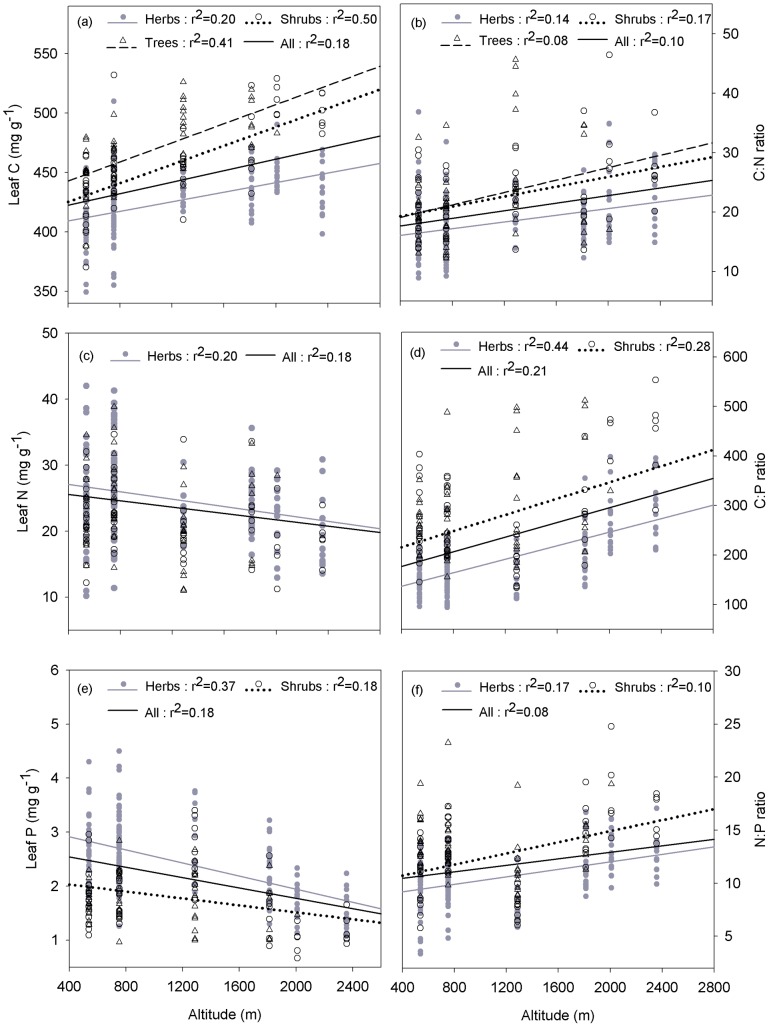
Changes in leaf C, N, P and C∶N∶P ratios with the altitudinal gradient.Lines are plotted if regressions were significant at P<0.05. Note log scale used on y-axis.